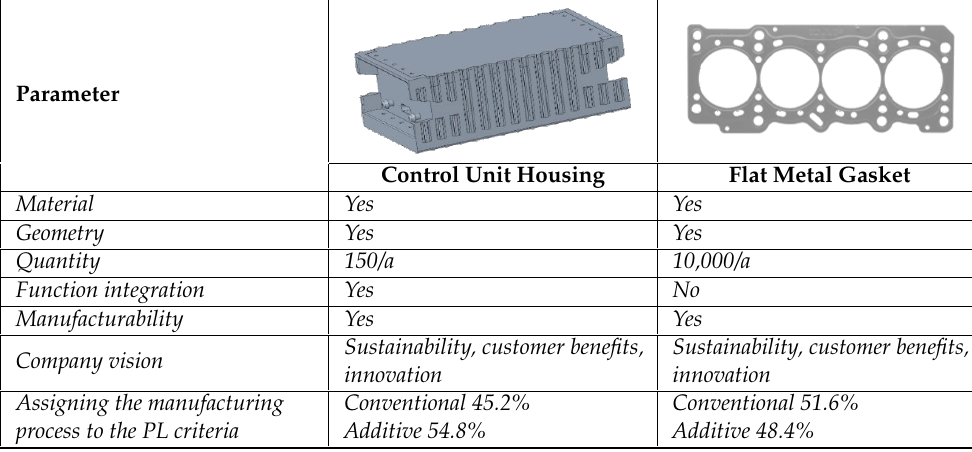
Table 4. Overview of the frameworks (control unit housing, left; flat metal gasket, right). Parameter